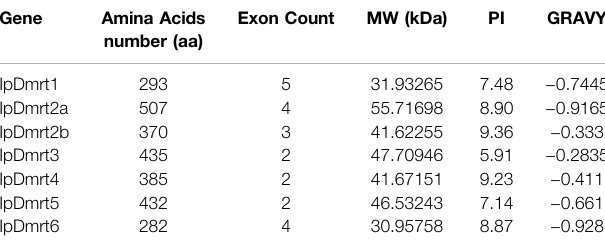
TABLE 1 | Basic physical and chemical properties of IpDmrt